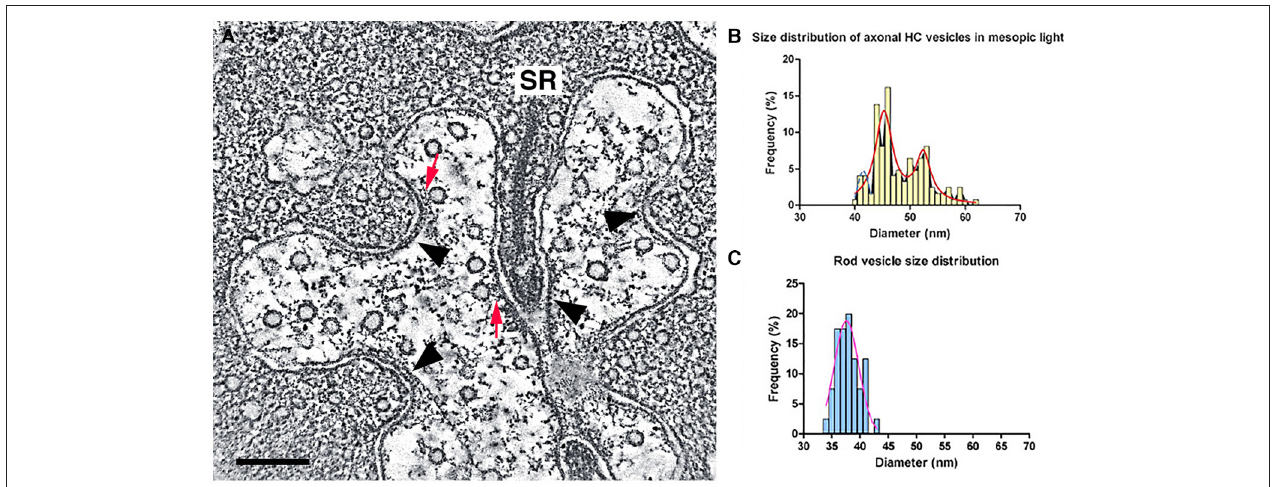
FIGURE 12 | Small, clear-core vesicles are present in horizontal cell endings in rod spherules and cone pedicles. (A) A mouse rod photoreceptor spherule with a horizontal cell axonal terminal near the photoreceptor synaptic ribbon (SR) containing numerous small, clear-core vesicles. Clear-core vesicles represent small neurotransmitter-containing synaptic vesicles. The vesicles show fine fibrils extending from their membrane and in some examples, the vesicles are tethered to the plasma membrane or to plasma membrane specializations (red arrows). Plasma membrane specializations (arrowheads) are seen at infoldings of the horizontal cell endings and near the base of the synaptic ribbon. (B,C) Distribution of vesicle diameters in horizontal cell axonal endings (B) and in rod terminals (C) . Horizontal cell axonal vesicle diameters have a bimodal distribution, and overall horizontal cell axonal vesicle diameters are larger than rod photoreceptor vesicle diameters. (A) z-section (orthoslice) of a tomogram. Scale bar, 200nm. (Modified from Brecha et al., 2010; Zampighi et al., 2011).